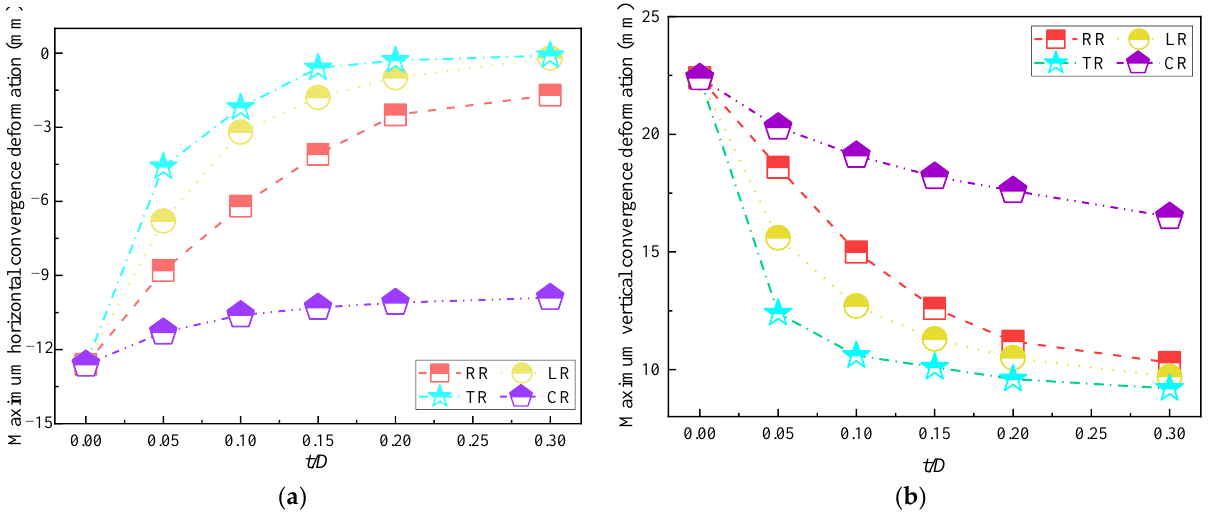
Figure 9. Variation of the maximum convergence of the preceding tunnel with t : ( a ) horizontal direction; ( b ) vertical direction.